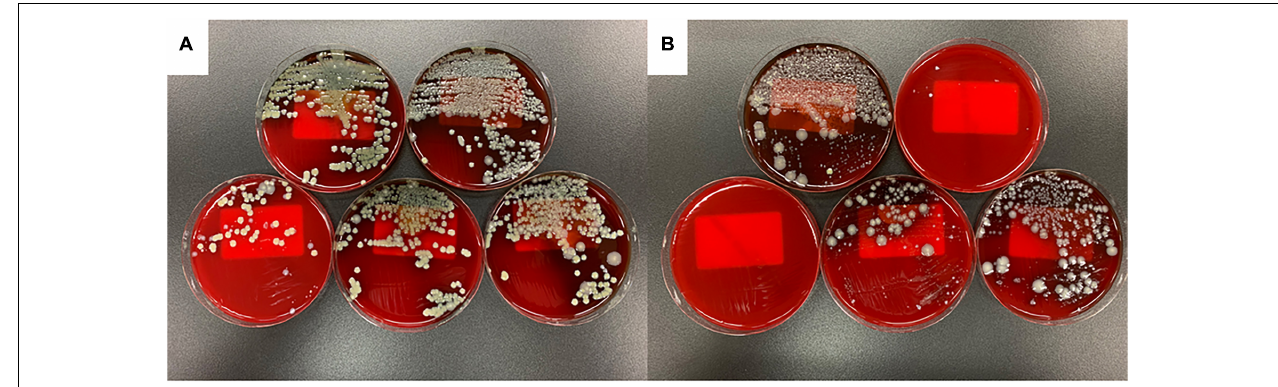
FIGURE 3 | Results of ascites culture of FSI and CLP models 20 h after surgery. Results, 24 h after the start of capneic incubation with Sheep Blood Agar (A) FSI model, (B) CLP